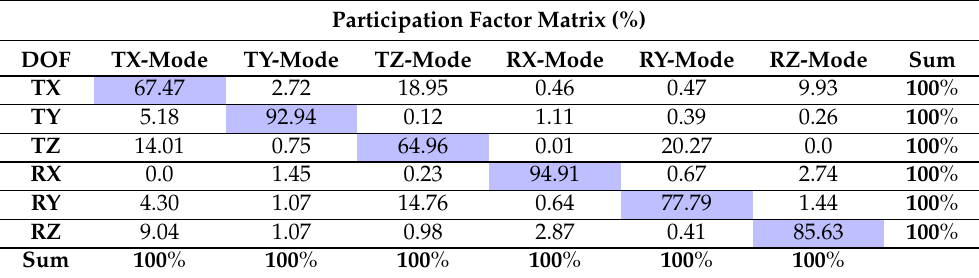
Table 1. Example of participation factor matrix. The sum of the coupling percentage columns is 100% when using the participation factor